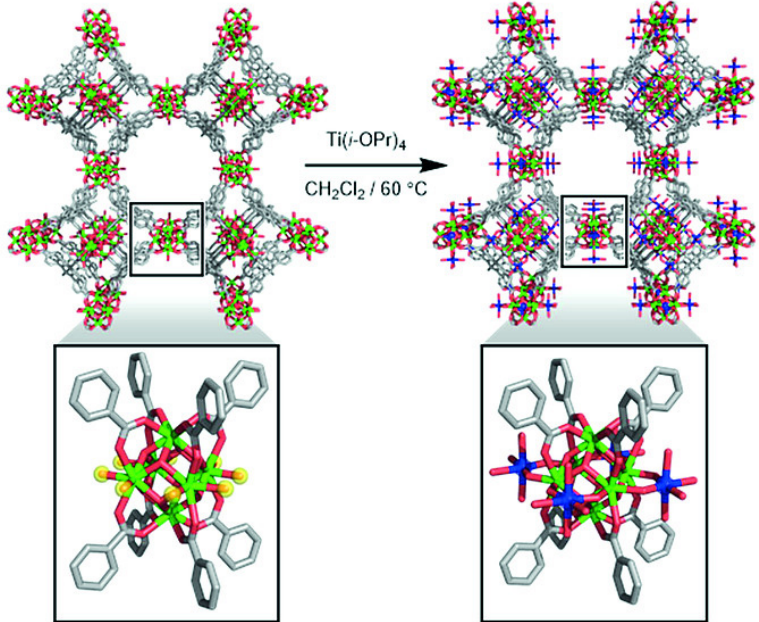
Figure 4. Synthetic scheme of Ti(IV) deposition on NU-1200, highlighting the exposed –OH/H 2 O groups of the Zr6 cluster that are available to post-synthetic metalation. Green = Zr, Blue = Ti, Red = O, Gray = C. Adapted with permission from [54]; Published by WILEY, 2016.